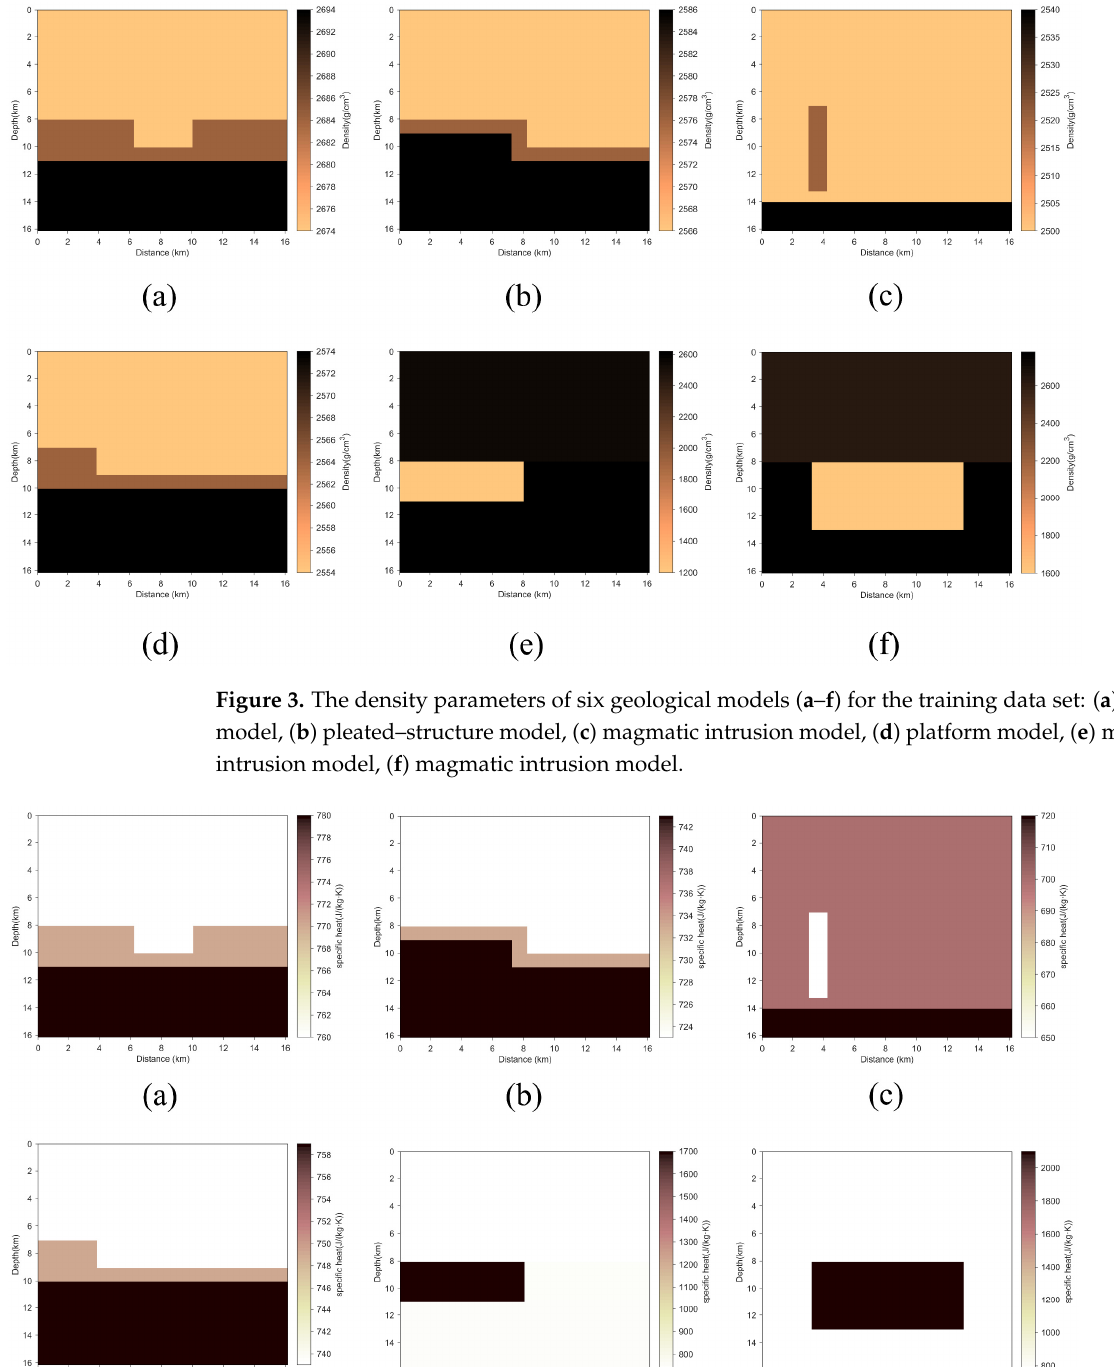
Figure 2. The six randomly selected geological models ( a – f ) from the training data set, ( a – f ) the six geological models contain different geological structures: ( a ) Graben model, ( b ) pleated − structure model, ( c ) magmatic intrusion model, ( d ) platform model, ( e ) magmatic intrusion model, ( f ) mag- matic intrusion model. Different geological models enrich the training data set.